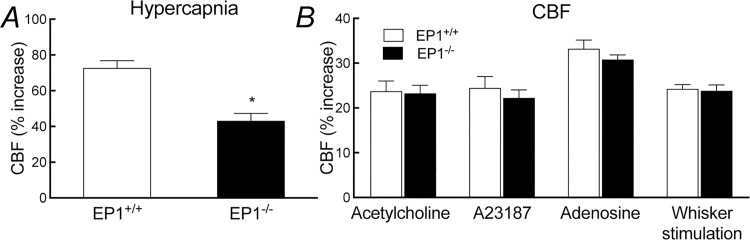
Cerebrovascular responses in EP1-/- mice.A, increase in CBF produced by hypercapnia; B, CBF response produced by acetylcholine, A23187, adenosine, or whsiker stimulation. * p<0.05, paired t-test; n = 5/group.